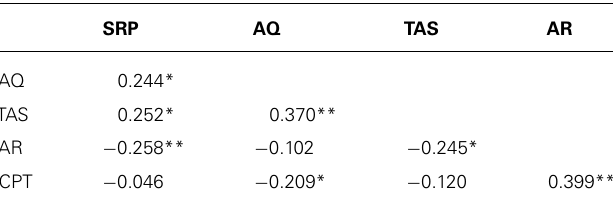
Table 1 | Correlations between questionnaire measures of psychopathic, autism spectrum disorder, and alexithymic traits and task